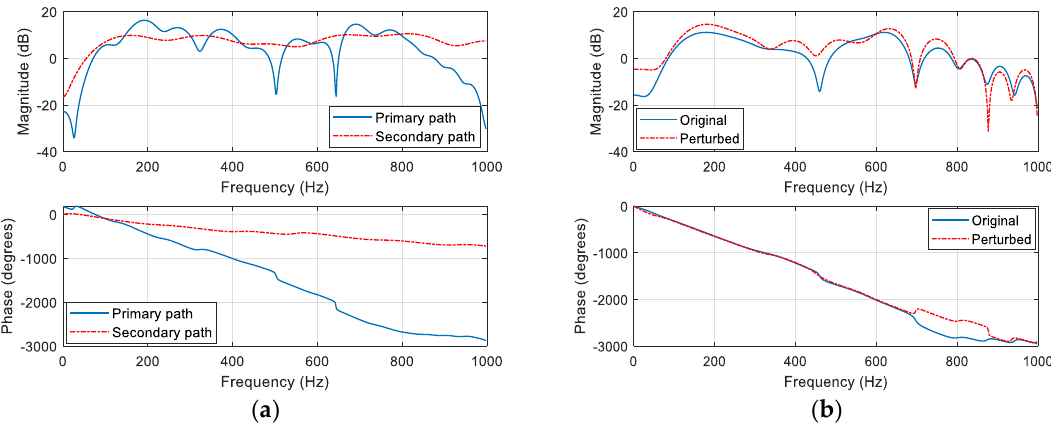
Figure 4. Frequency response of ( a ) the primary path and the secondary path and ( b ) feedback path.